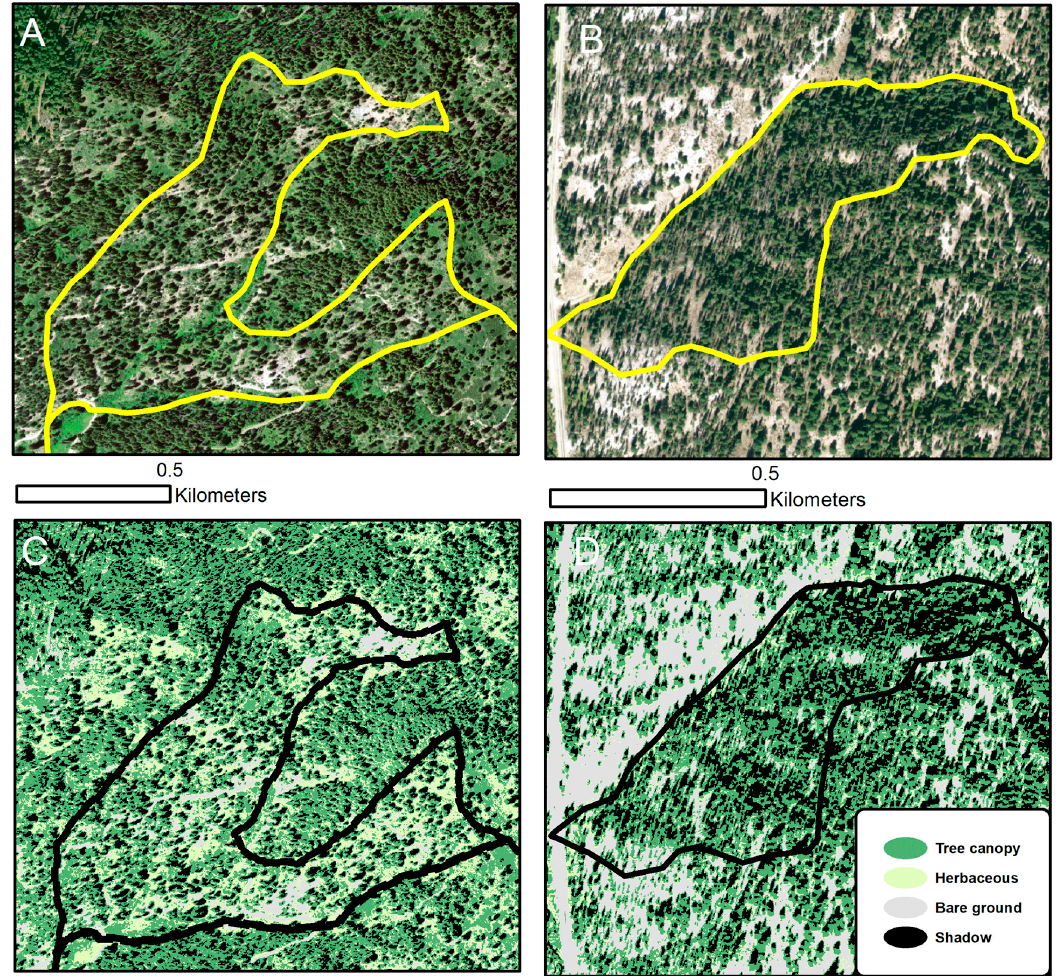
Figure 3. Illustration of canopy cover mapping for two stands. Aerial photos (NAIP 1 m resolution) of two stands ( A and B ) and corresponding maximum likelihood classifications ( C and D ). Canopy cover for images A and B was estimated at 70.9% and 94.2% via classified images C and D .